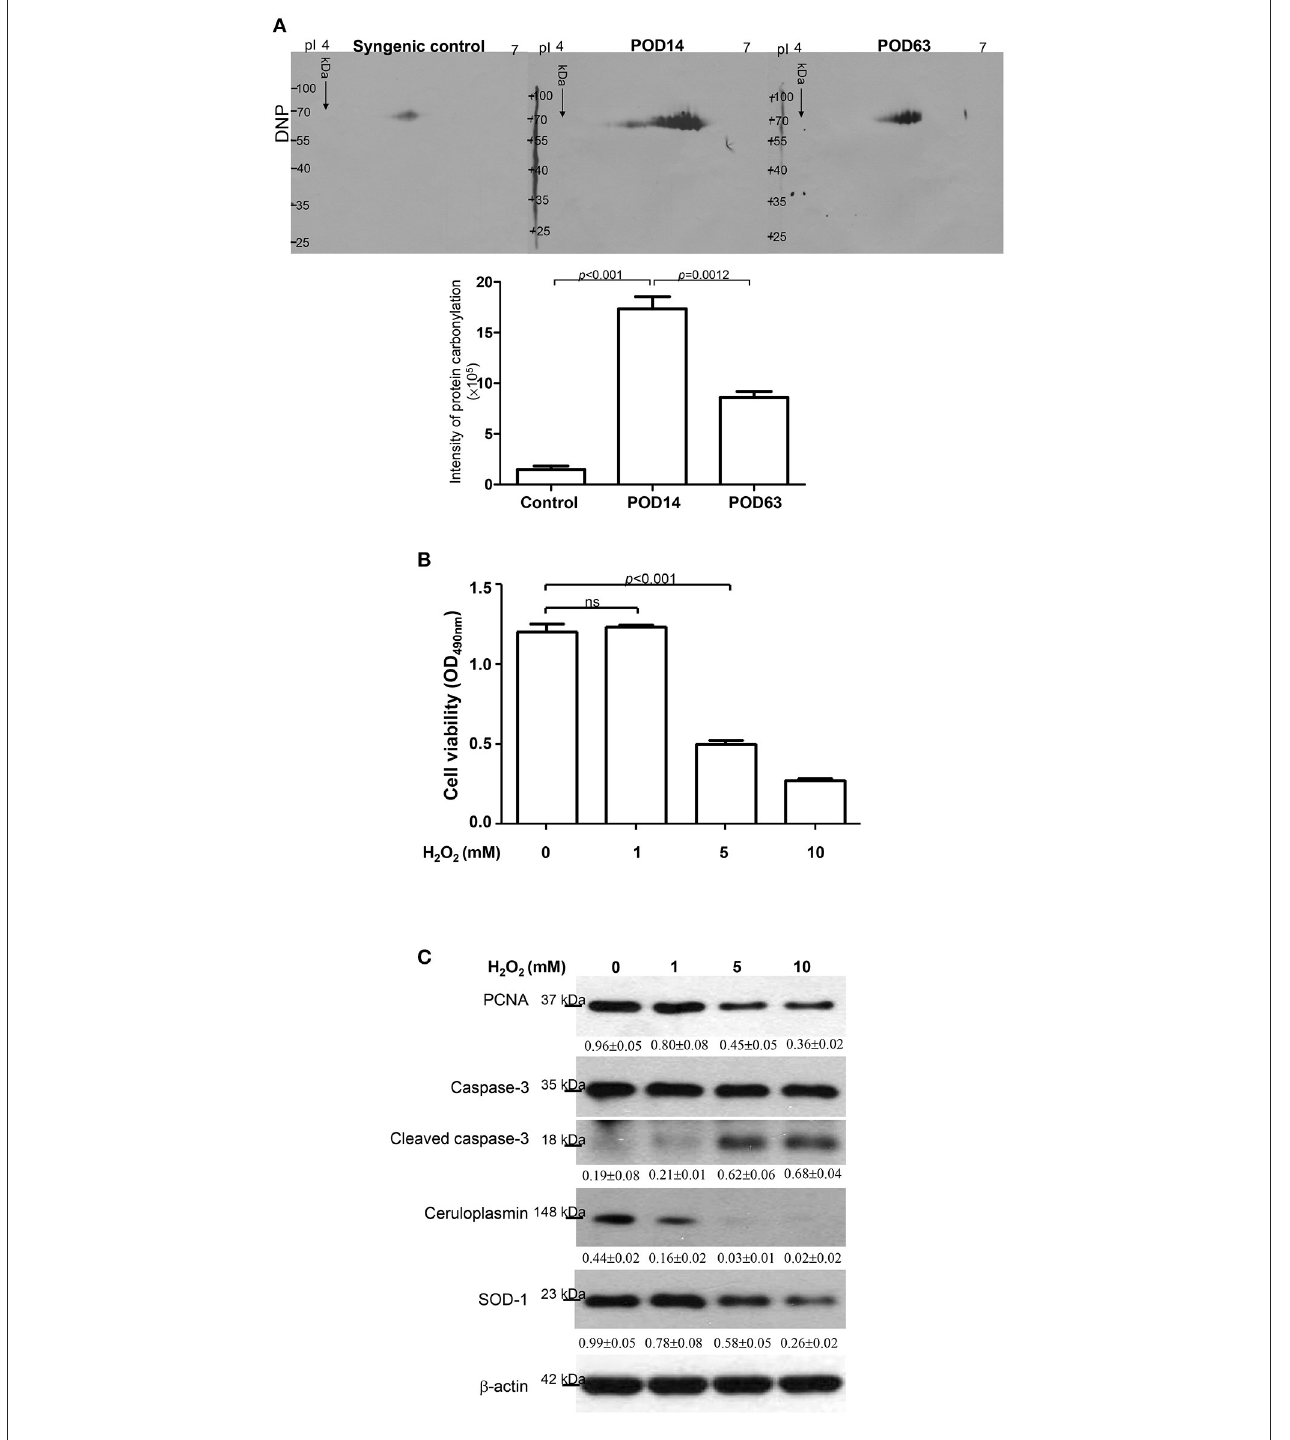
FIGURE 3 | (A) Images of the 2-DE oxyblot. Analysis of protein oxidation levels in DNP-derivatized proteins among syngenic control, POD14 and POD63 samples. Obvious reduction in the carbonylation levels of proteins are observed in the tolerance group compared to rejection group. The quantitative results indicating the differentially carbonylated level of protein on syngenic control, POD14 and POD63 were demonstrated as the bar chart. (B) HepG 2 cell viability was determined under the treatments of 0, 1, 5 and 10mM H 2 O 2 . The result was quantified and indicated by the bar chart. (C) Western blotting analysis for PCNA, caspase-3, ceruloplasmin and SOD-1 levels under treatment of different concentrations of H 2 O 2 . The relative expression ratio to β -actin is shown at the bottom.